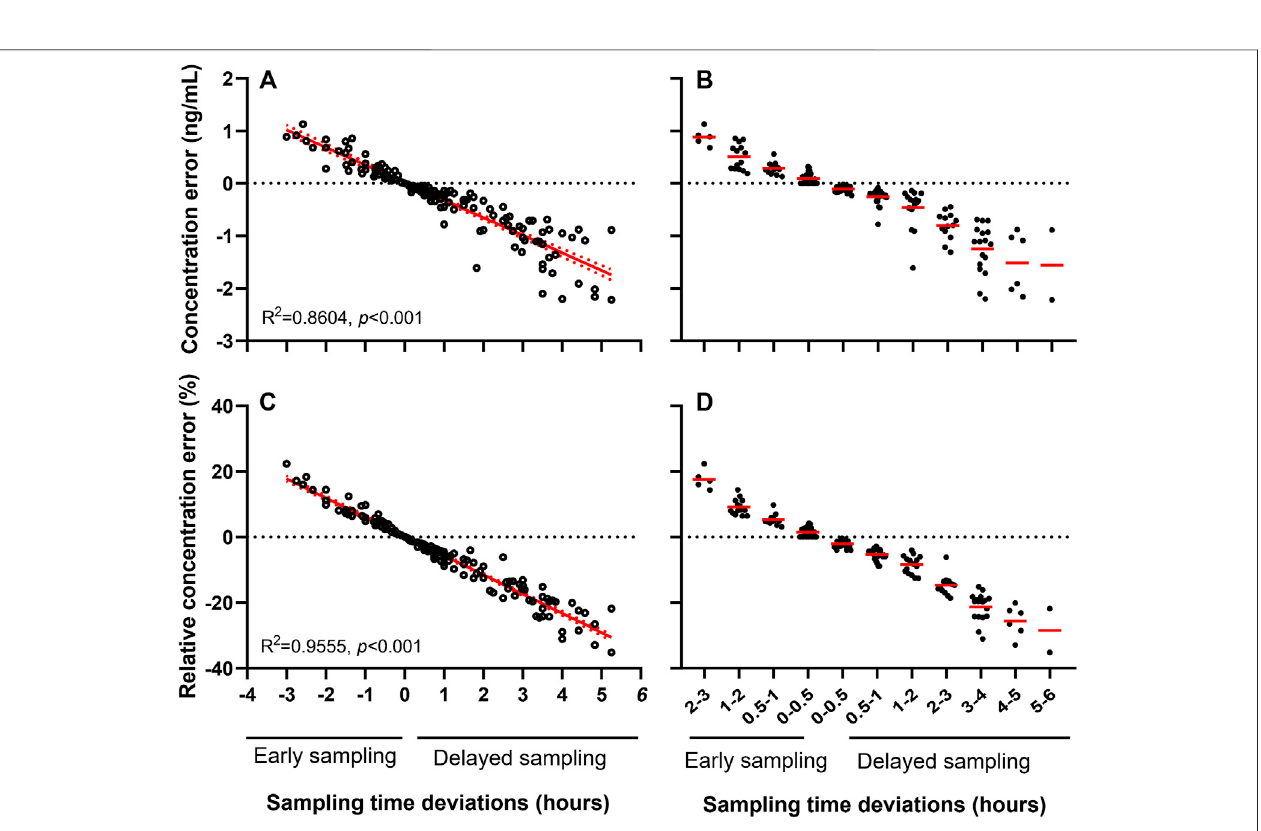
Frontiers in Pharmacology |